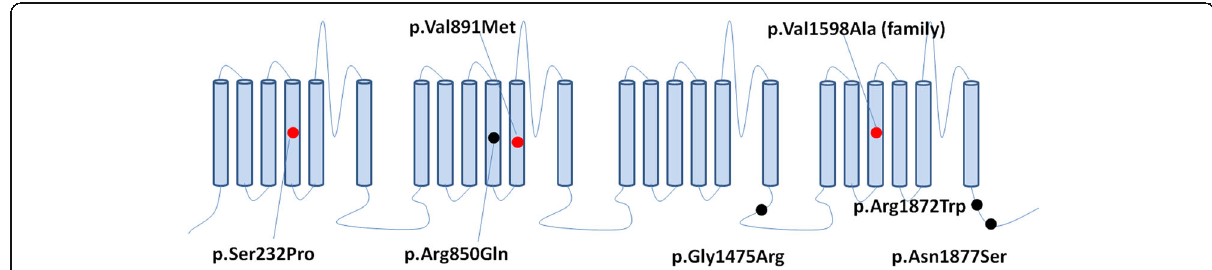
Fig. 3 The structure of the human Nav1.6 channel and the location of SCN8A mutations identified in this study. Red Dots: Novel; black dots: